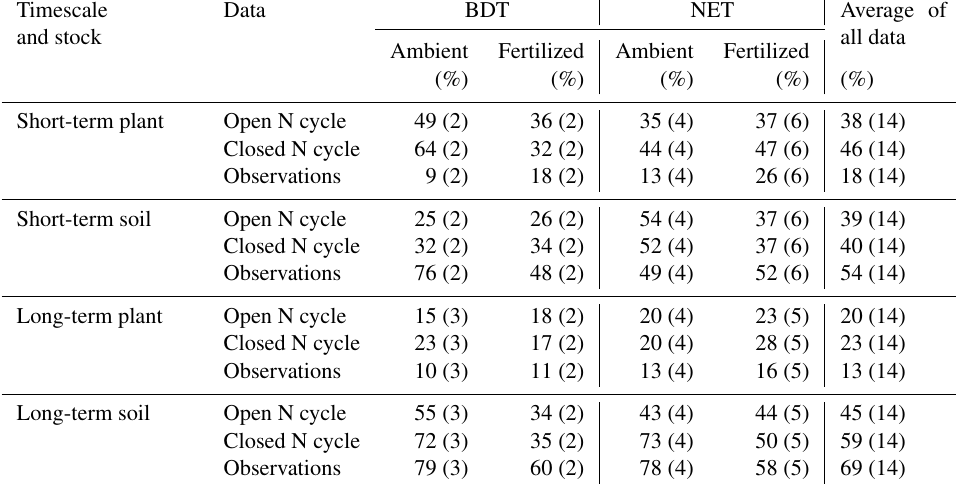
Table 4. N recovery in CLM5 simulations using an open N cycle (i.e., the default version of CLM5) and a closed N cycle compared to observations for plant and soil stocks in the short ( < 3 years) and long term ( > 3 years). Data are separated according to PFT (i.e., broadleaf deciduous temperate, BDT, and needleleaf evergreen temperate, NET, trees) and fertilization treatment, as well as aggregated across all sites (combined across PFTs and fertilization treatment). The number of data points for each N recovery is listed in parentheses. Timescale Data BDT NET Average of and stock all data Ambient Fertilized